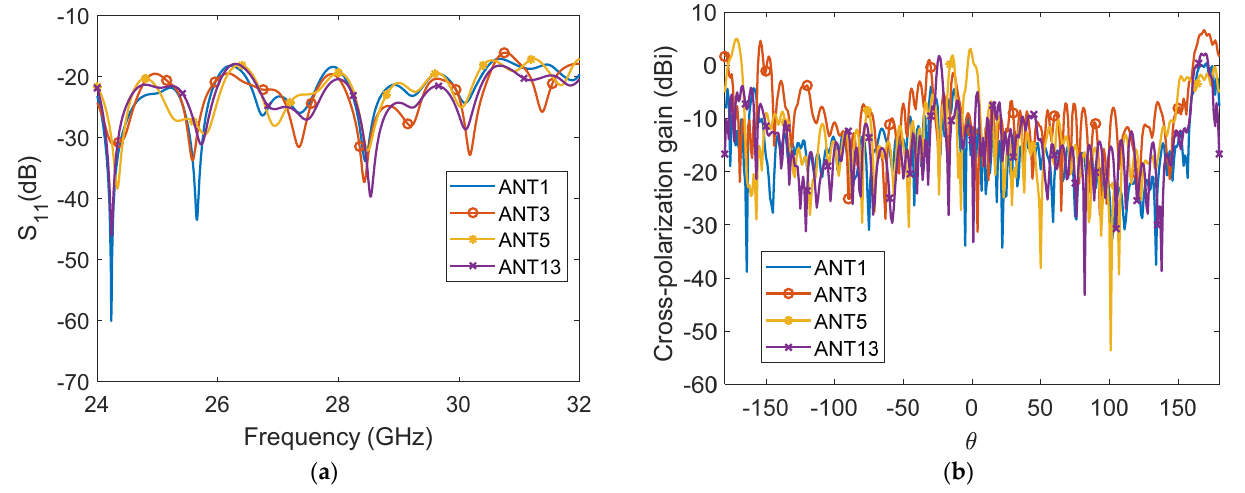
Figure 9. ( a ) The reflected scattering parameter and ( b ) cross-polarization gain of four selected antennas.